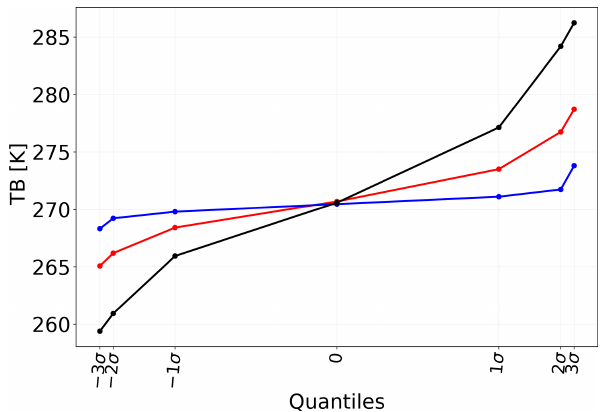
Figure 2. Examples showing the predicted quantiles of the condi- tional distribution of y NFCS